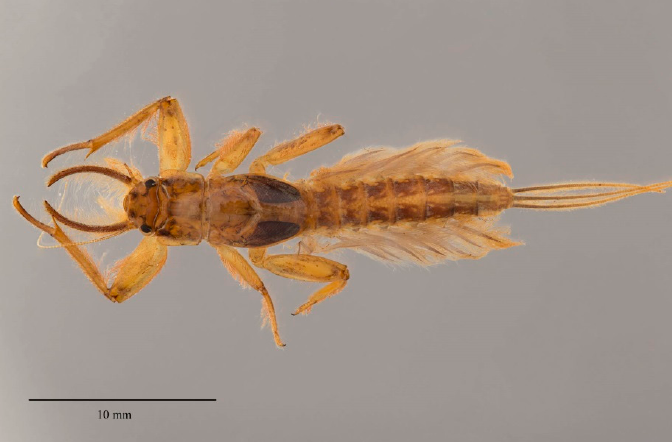
Figure 6. Arthroplea congener Bengtsson (Heptageniidae, Switzerland) in dorsal ( a ), and lateral ( b ) view: head, with maxillary palps clearly visible on the sides that are used to create filtering vortices.